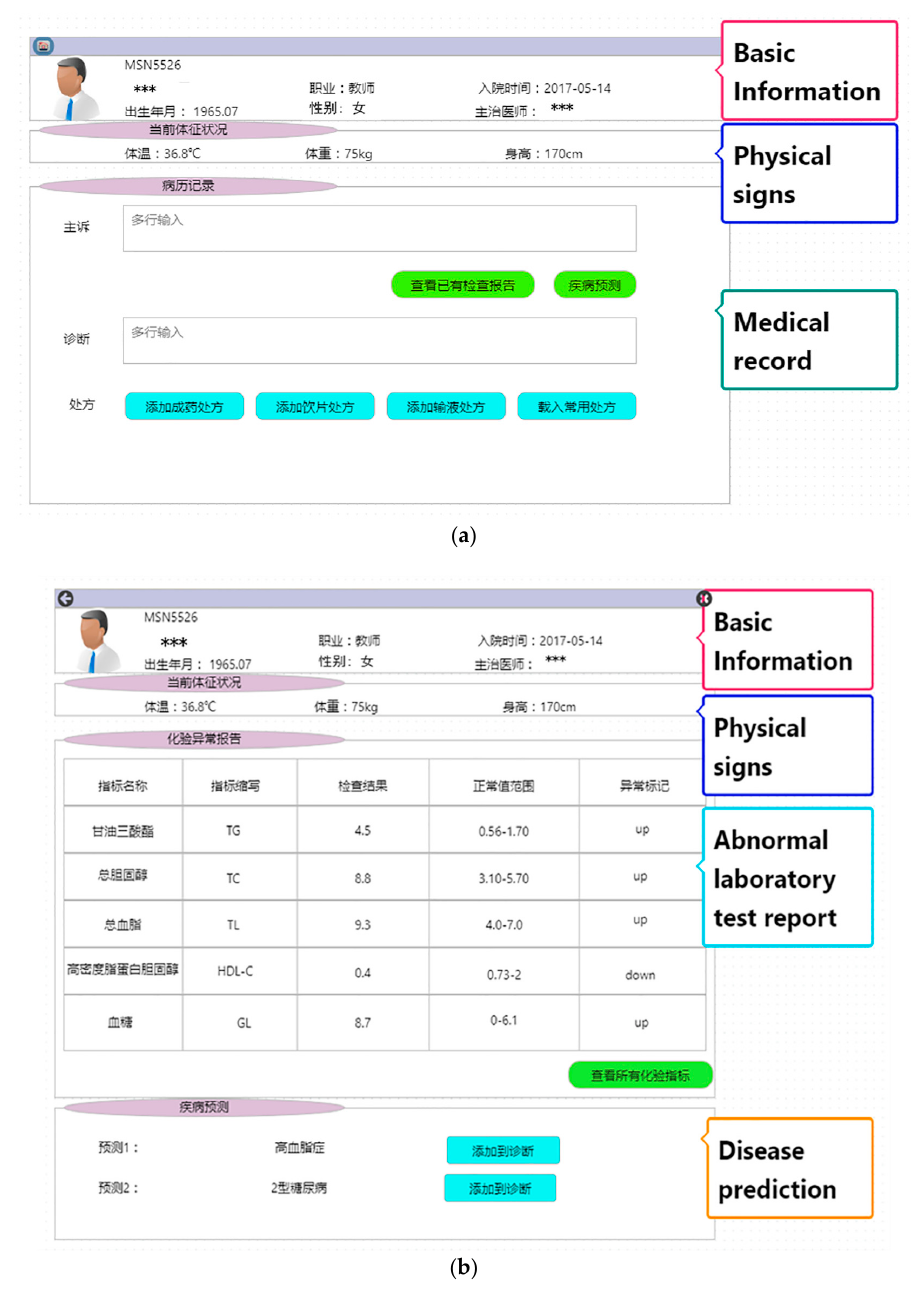
Figure 7. Two screenshots of the developed system using COCOA-RE approach: ( a ) the main work interface for clinicians; ( b ) the interface for viewing the laboratory test report.